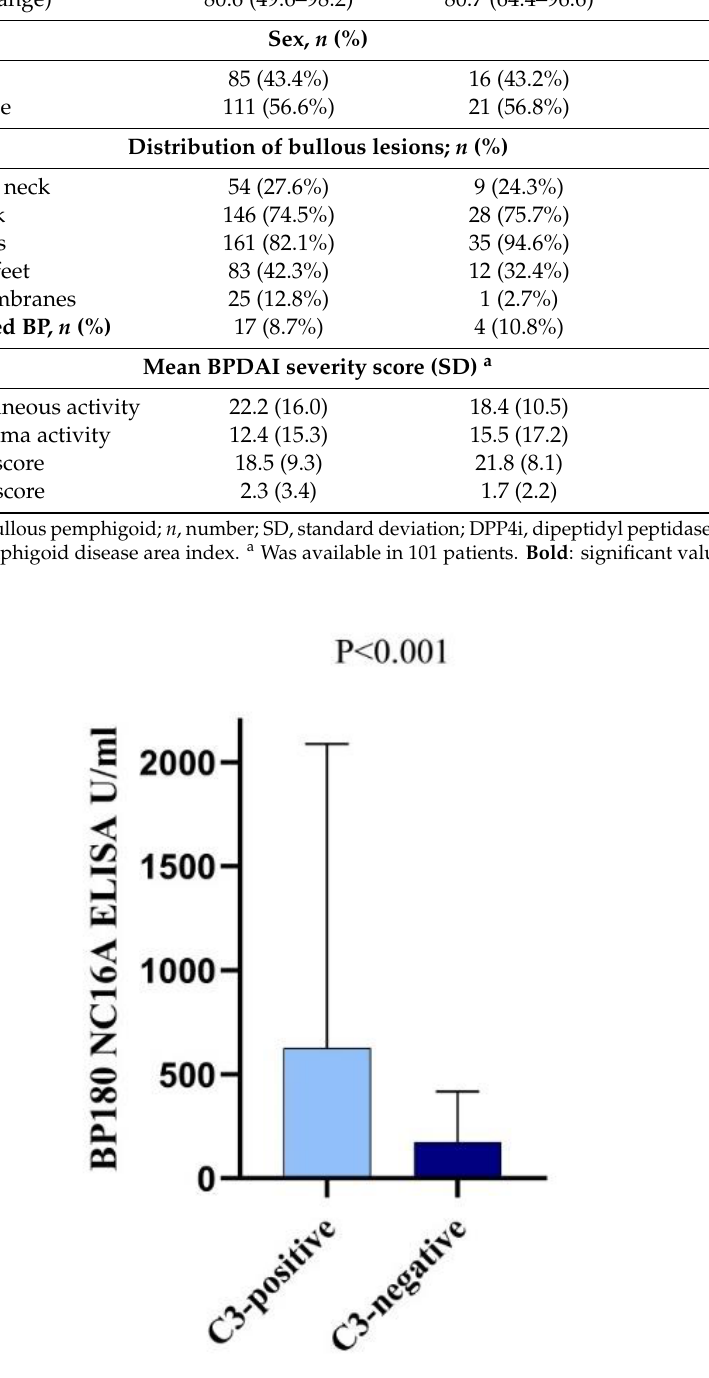
Figure 1. Anti-BP180 NC16A IgG levels of BP patients with linear C3 deposition relative to BP patients without C3 deposition at the dermal–epidermal junction by direct immunofluorescence microscopy. The lines represent the mean values. Table 2. Immunological characteristics and laboratory findings of BP patients with C3 deposition by DIF as compared to BP patients without C3 deposition.